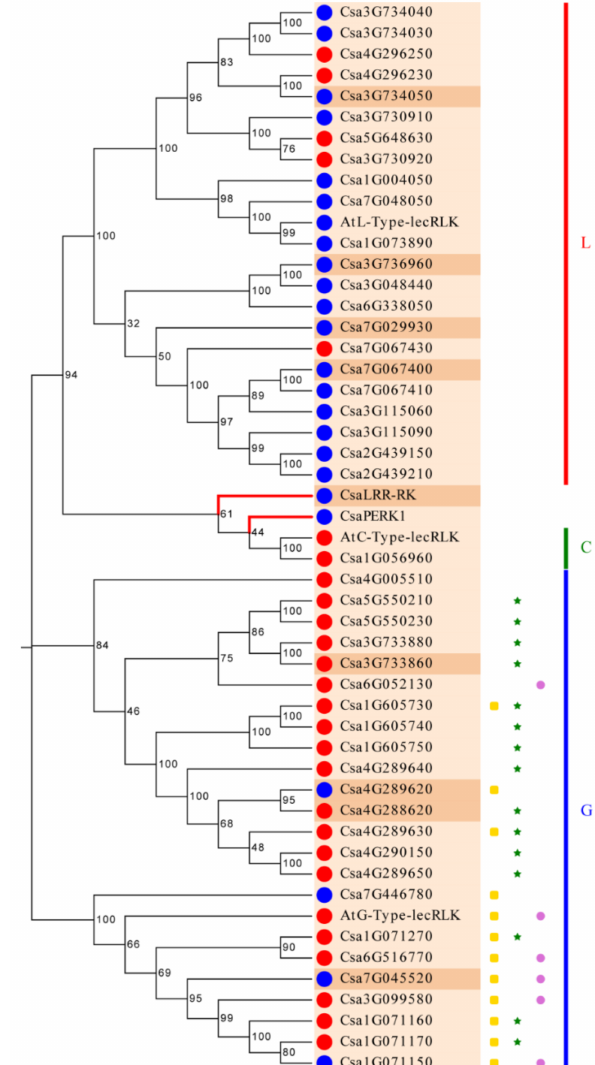
Figure 2. Rooted Phylogenetic tree construction and structure analysis of CsLecRLK s. The L, G and C respectively represent the L-type, G-type and C-type LecRLK subfamilies. The blue circles in front of CsLecRLKs represents proteins with a signal peptide, the red circles in front of CsLecRLKs